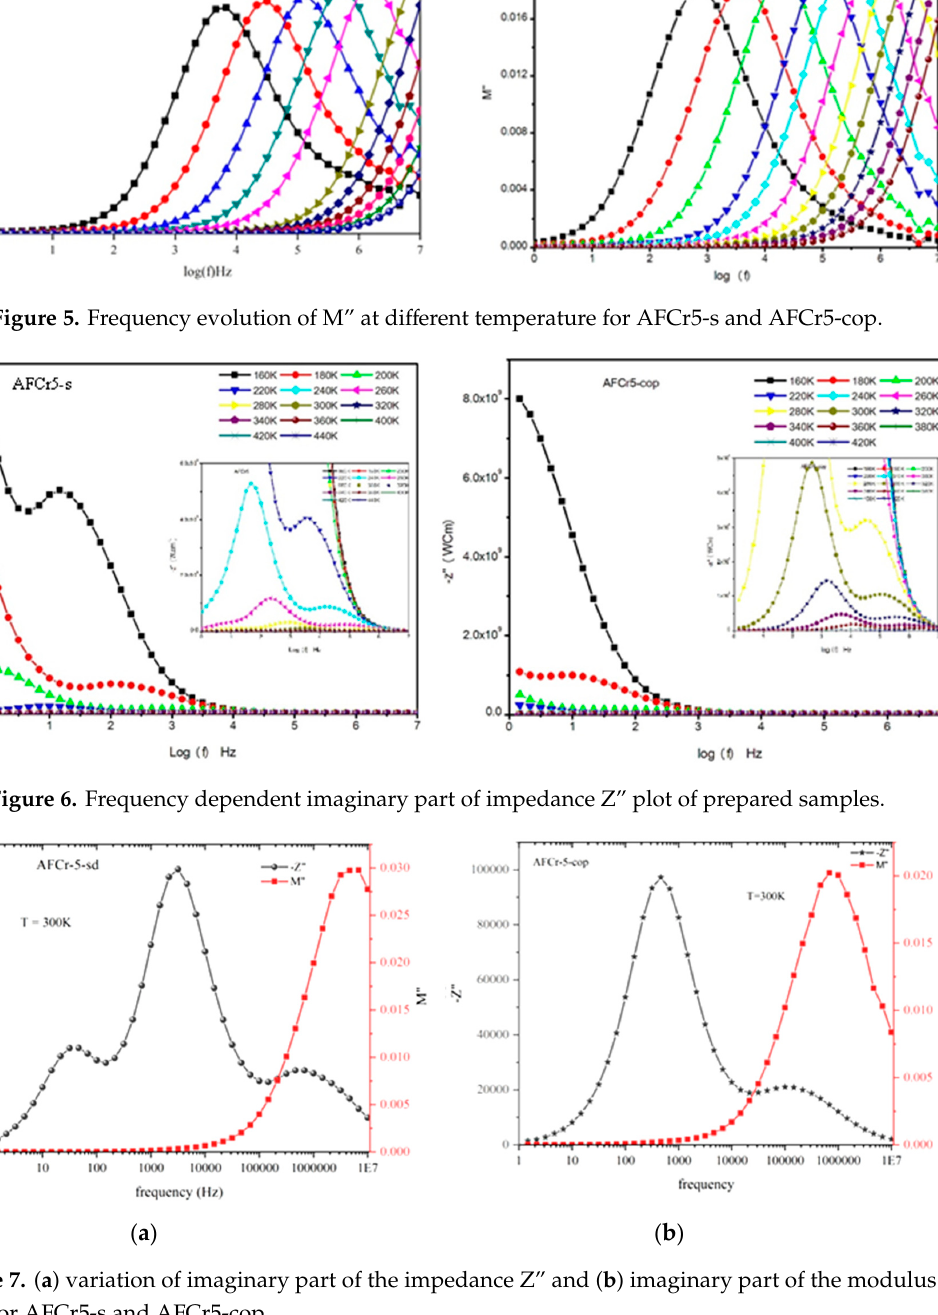
Figure 7. ( a ) Variation of imaginary part of the impedance Z’’ and ( b ) imaginary part of the modulus (M”) for AFCr5-s and AFCr5-cop. (M”) for AFCr5-s and